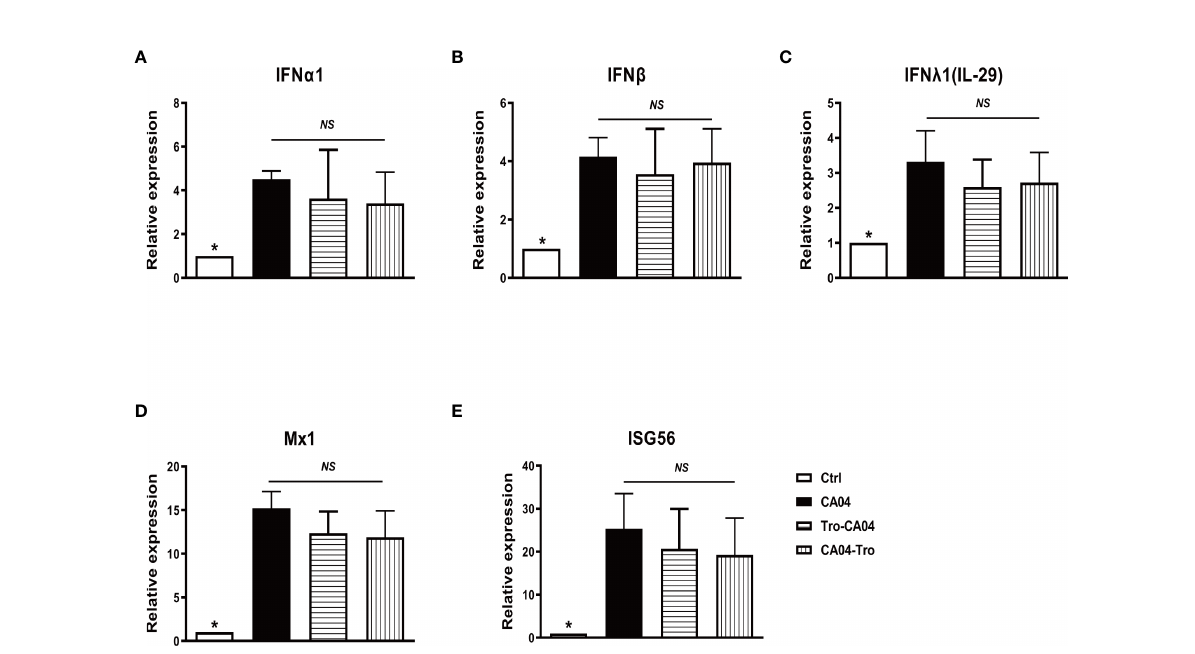
FIGURE 3 PPAR g agonist does not alter in fl uenza-induced IFN production and IFN downstream signaling. Cultured human AMs were infected with CA04 at MOI=1, and PPAR g agonist troglitazone (5 m M) (Sigma, St Louis, MO) was given 1 h before or after infection. After infection, cells were cultured with an agonist for another 24 h. At 4 or 24 hpi, the cell pellet was harvested for RNA extraction, and the expression level of indicated genes was determined by RT-qPCR. (A) IFN a . (B) IFN b . (C) IFN l . (D) Mx1. (E) ISG56. Mann-Whitney test was apllied for the statistical analysis between CA04 and non- infected control conditions. Ordinary one-way ANOVA was applied for the statistical analysis among CA04, Tro-CA04 & CA04- Tro conditions. ns means no signi fi cance. *p <